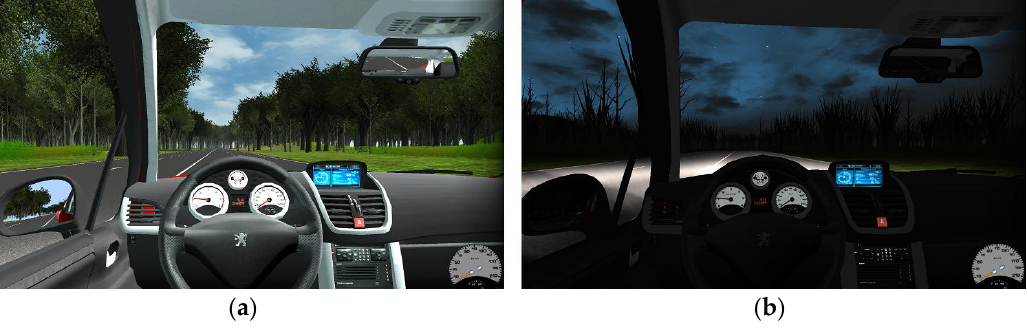
Figure 7. Sample screen shots for the 3D environment: ( a ) Daytime driving; ( b ) Nighttime driving.